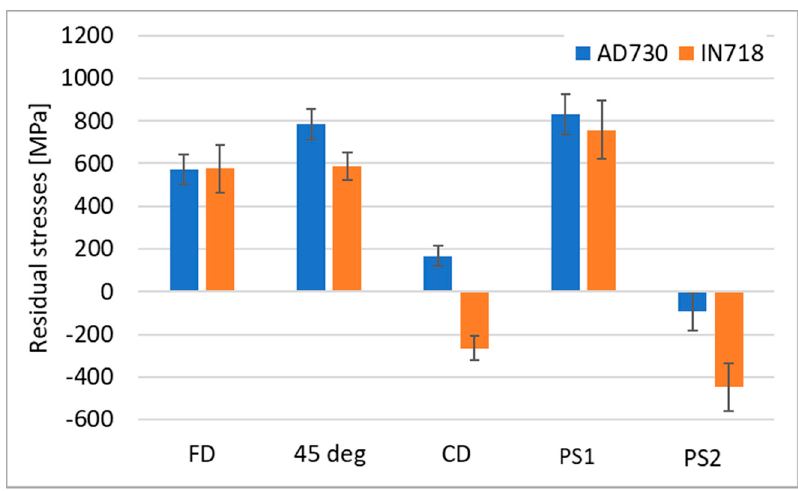
Figure 10. Surface residual stresses measured in the cutting direction (CD), feed direction (FD), and 45° to the FD as well as the derived principal stresses (PS1 and PS2) for AD730 ® and IN718.